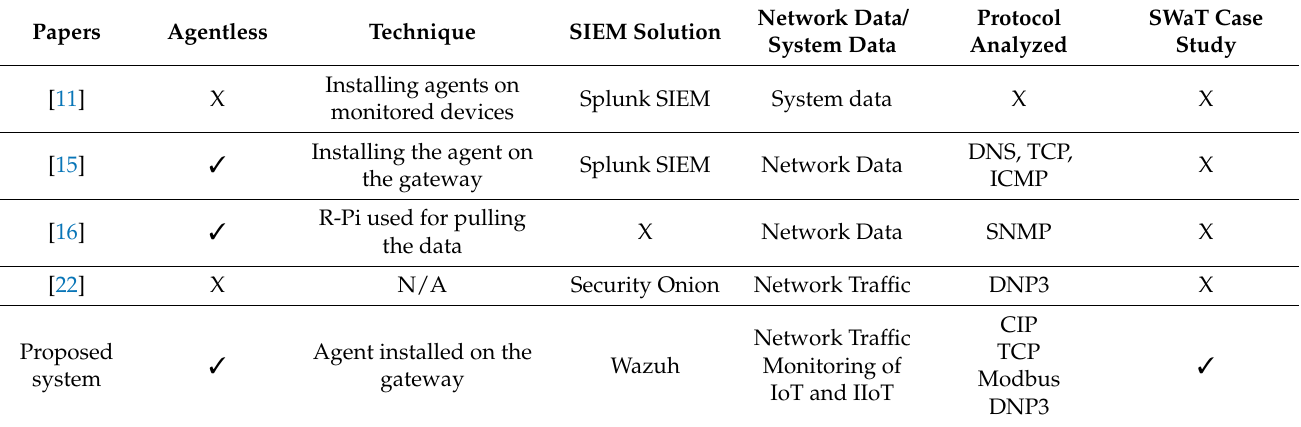
Table 1. Comparison of Relevant Approaches for IoT Security Using